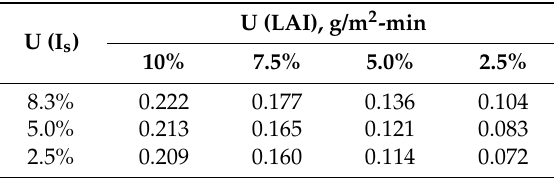
Table 7. The effect of uncertainty of the leaf area index (LAI) and solar intensity (I s ) in the uncertainty analysis for the Baille ET m equation.